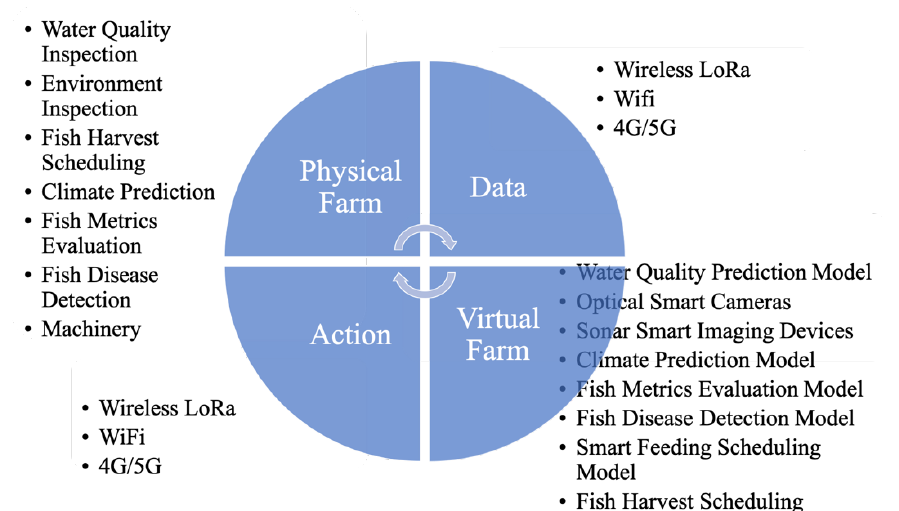
Figure 4. User requirement analysis of intelligent fish farming using digital twins [9].